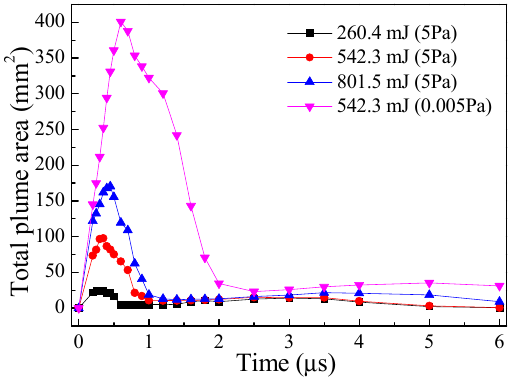
Figure 21. The total plume area variation with time at different energies (ambient pressure 5 Pa and 26.5% Al).